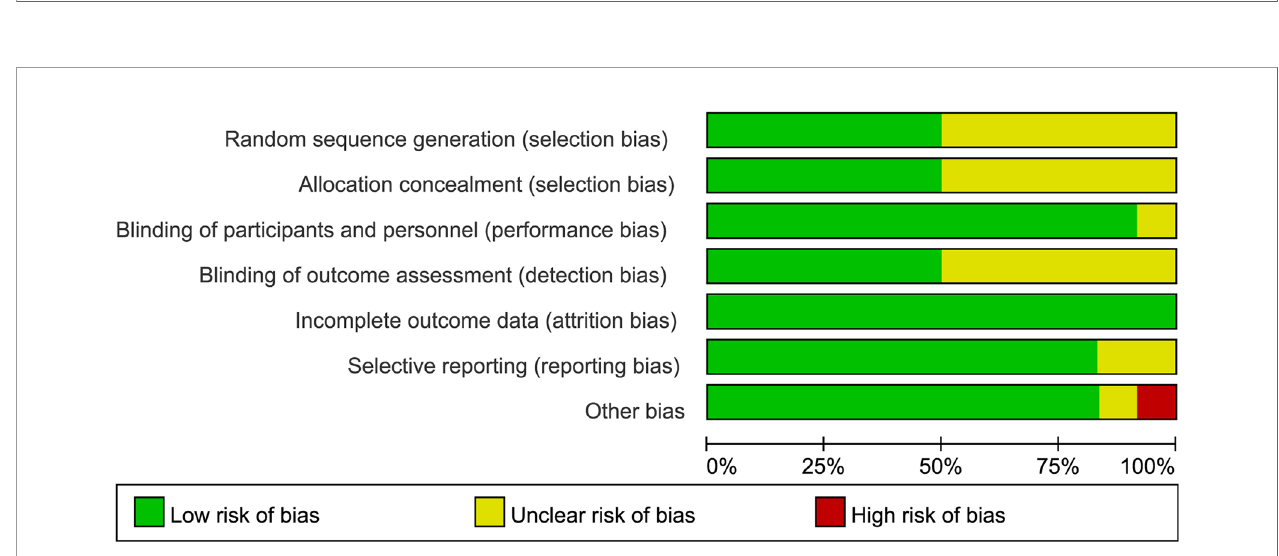
FIGURE 3 | Risk of bias and applicability concerns